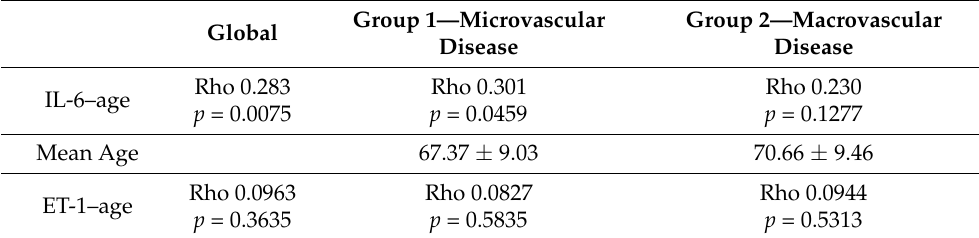
Table 3. The relationship between IL-6 and ET-1 values and patients’ age. Group 1—Microvascular Global Disease